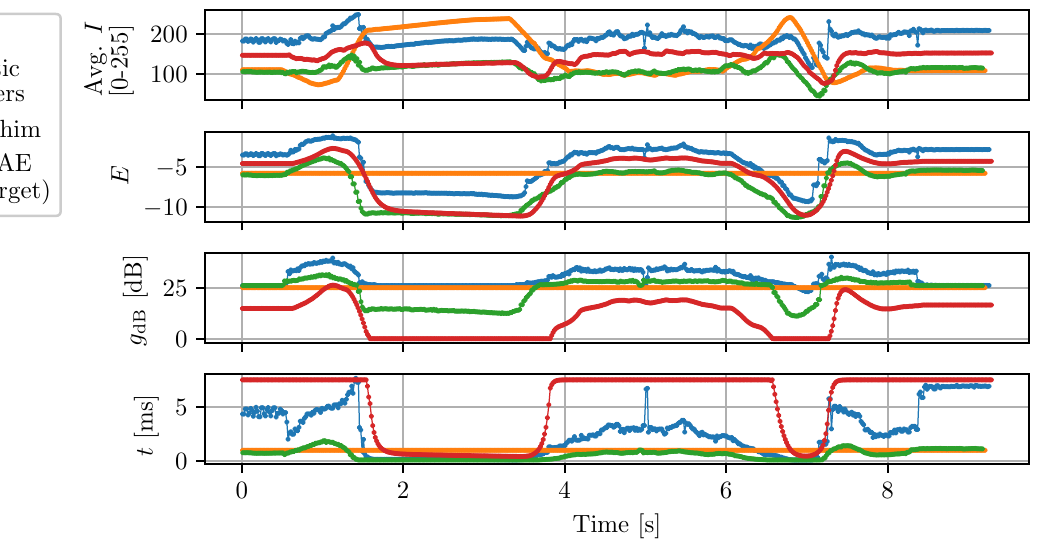
Figure 14. Comparison of the image exposure parameters selected by different AE algorithms. Light intensity captured by the cameras oscillates between 1 lux for the darker parts of the scene and 217 lux for the brighter parts (e.g., over the 1.5–3.5 s and 6.5–7.0 s